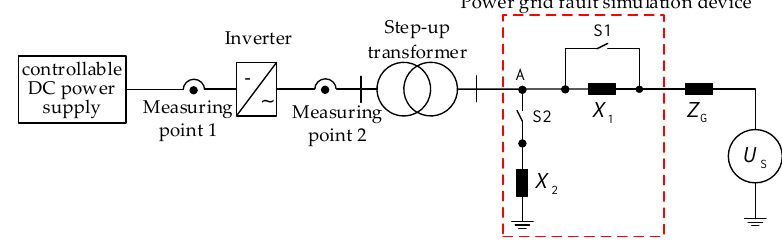
Figure 10. Schematic diagram of the test system.